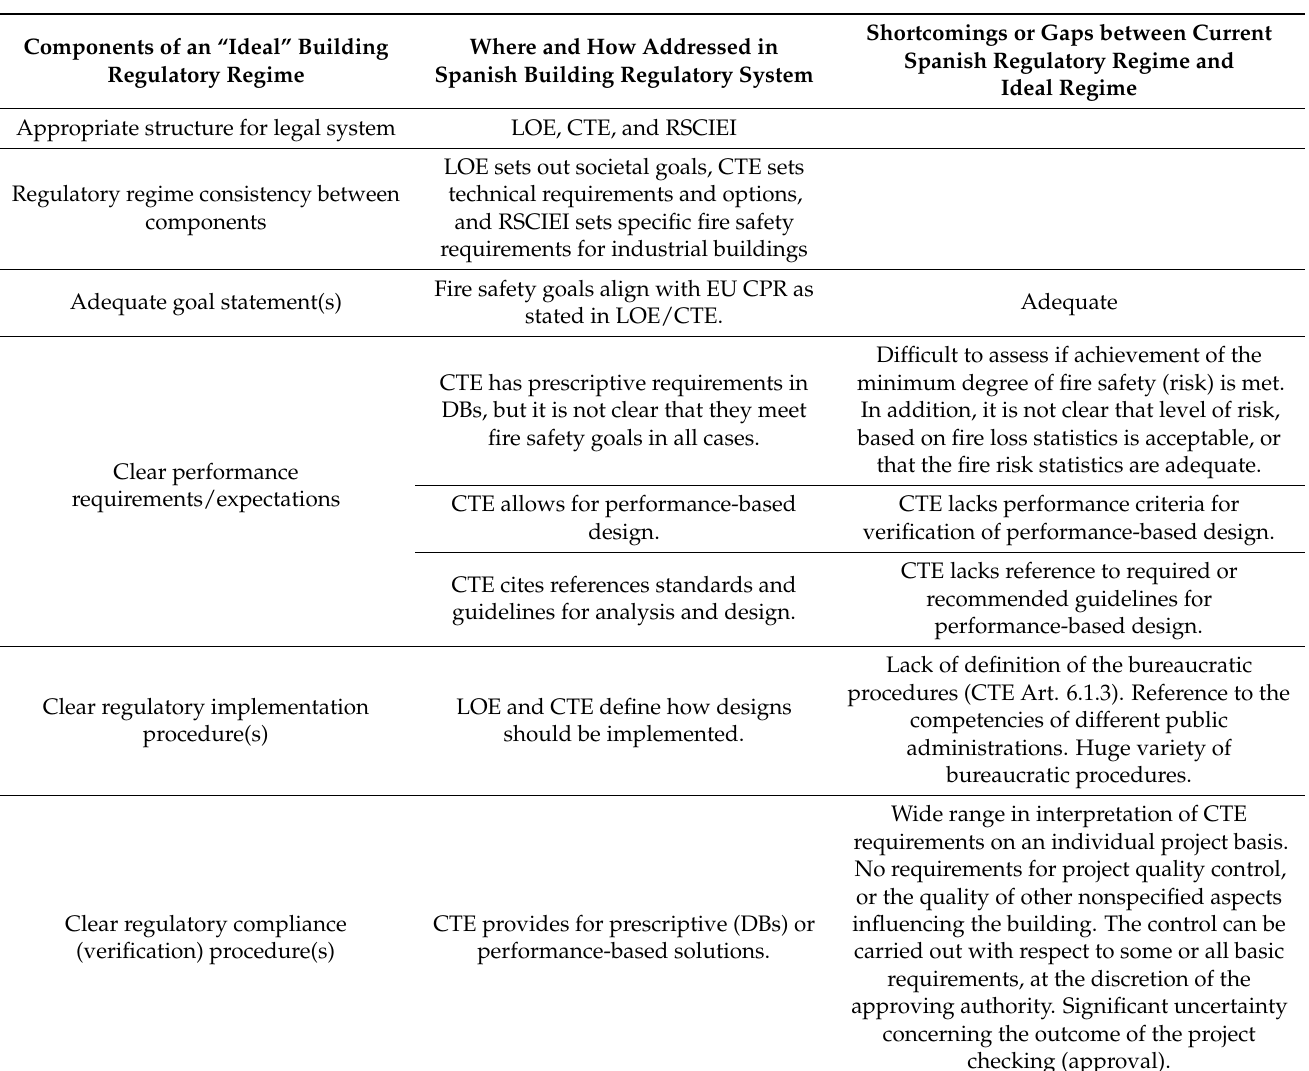
Table 11. Identified drawbacks concerning the components of an “ideal” building regulatory regime. Components of an “Ideal”